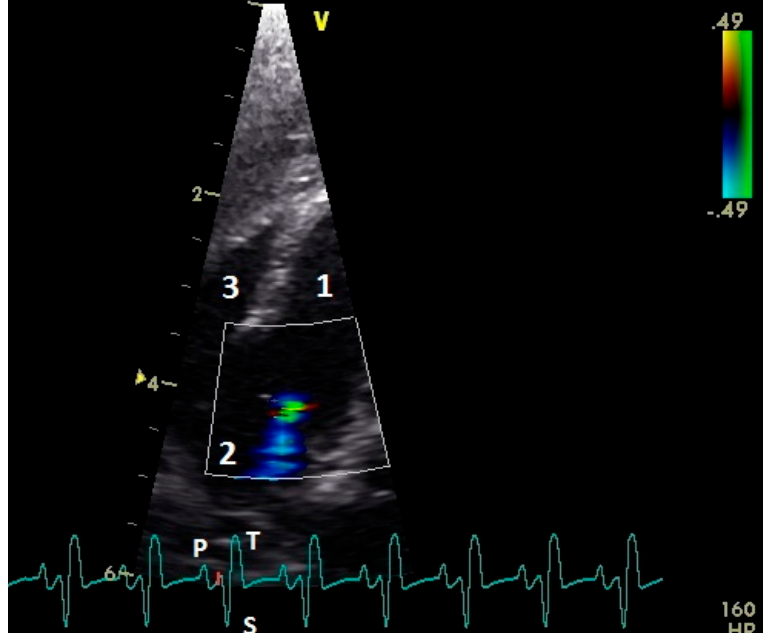
Figure 4. Color flow image of the left atrioventricular valve region of an anesthetized racing pigeon with a valvular insufficiency (blue color) in the preejection period after the active ventricular filling and before the systolic ventricular contraction (red mark on electrocardiogram). 1: left ventricle; 2: left atrium, and 3: right ventricle. Electrocardiogram: P: P wave; S: S wave; and T: T wave.